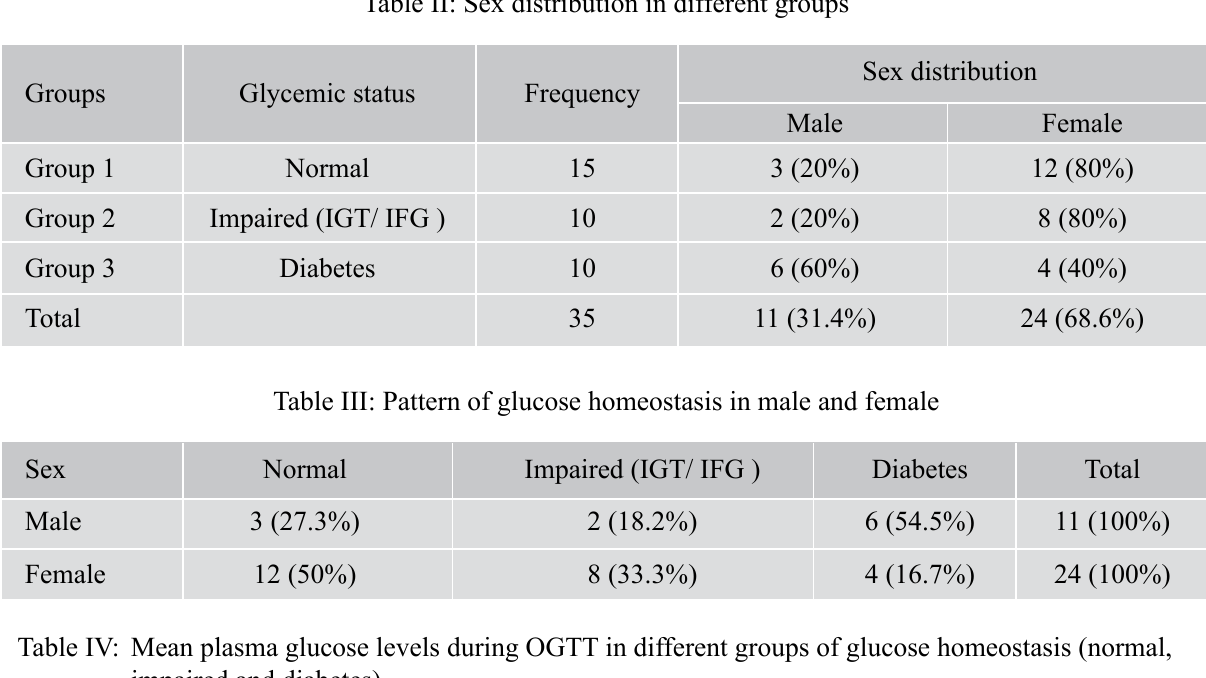
Table II: Sex distribution in different groups